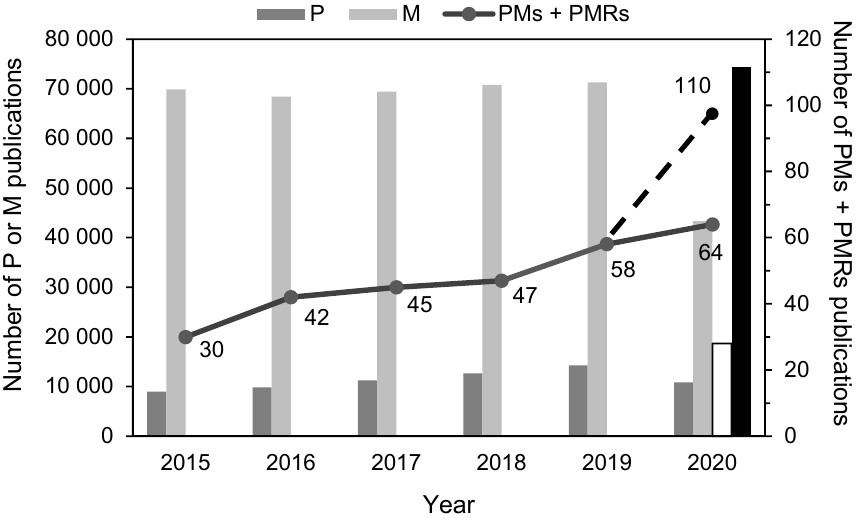
Figure 1. Development of publications on photocatalysis (P), membranes (M), and photocatalytic membranes + photocatalytic membrane reactors (PMs + PMRs) (Scopus, 31 July 2020). The data for 2020 represent the status at 31 July 2020. Additionally, the data for 2020 were extrapolated for the whole year assuming a constant rate of publishing (white and black bars, and black point with dotted line). Keywords: P—photocatal*; M—membrane; PMs + PMRs—“photocatalytic membrane” AND “membrane photoreactor”.